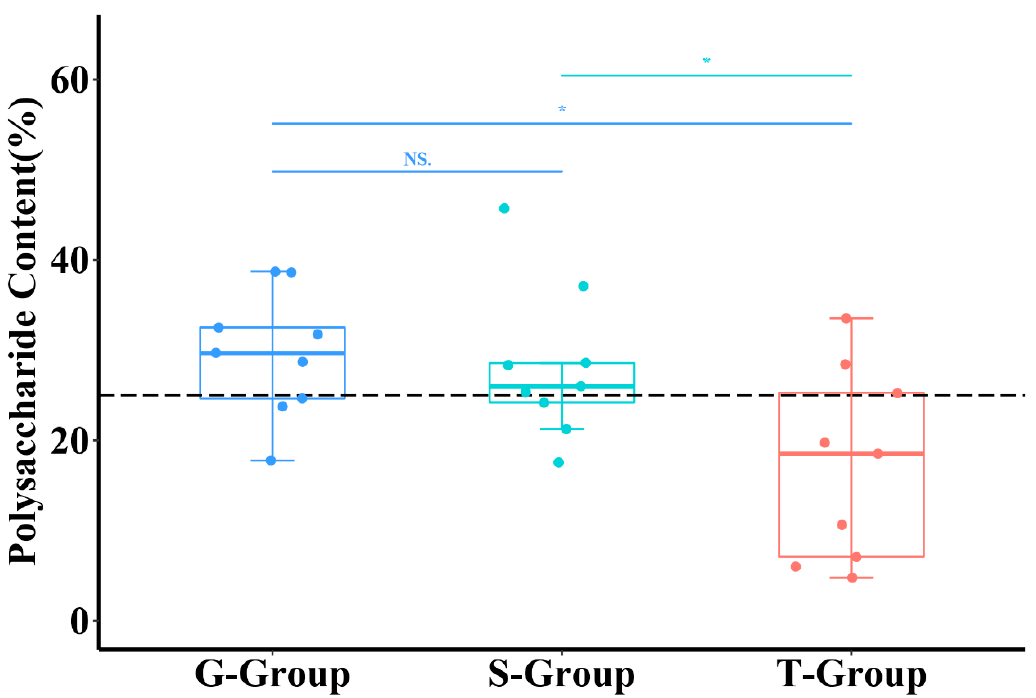
Figure 1. The effects of different cultivation methods on polysaccharide content ( n = 9). Each point represented one sample. The G-Group meant that the sample was from greenhouse cultivation; S-Group meant that the sample was from stone epiphytic cultivation; T-Group meant that the sample was from live tree epiphytic cultivation. The dotted line indicated the polysaccharide content was equal to 25%. Furthermore, * represented p < 0.05, and NS represented that there was no statistical difference.